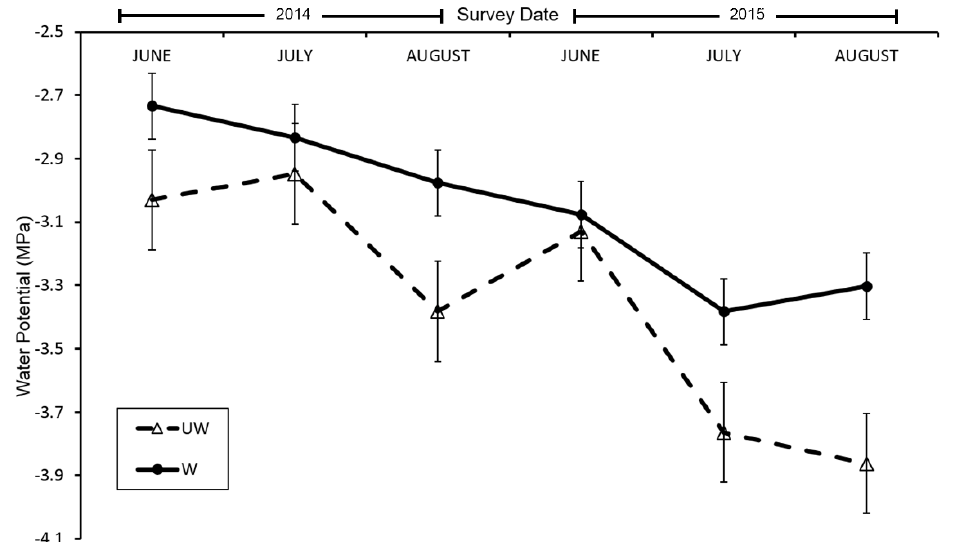
Figure 1. Mean xylem water potential per tree during each summer month of the two-year study. Water potential became more negative over the course of each summer and was statistically more negative in 2015 and in unwatered trees ( p < 0.05). Error bars are the standard error of mean values. W = watered and UW = unwatered trees.